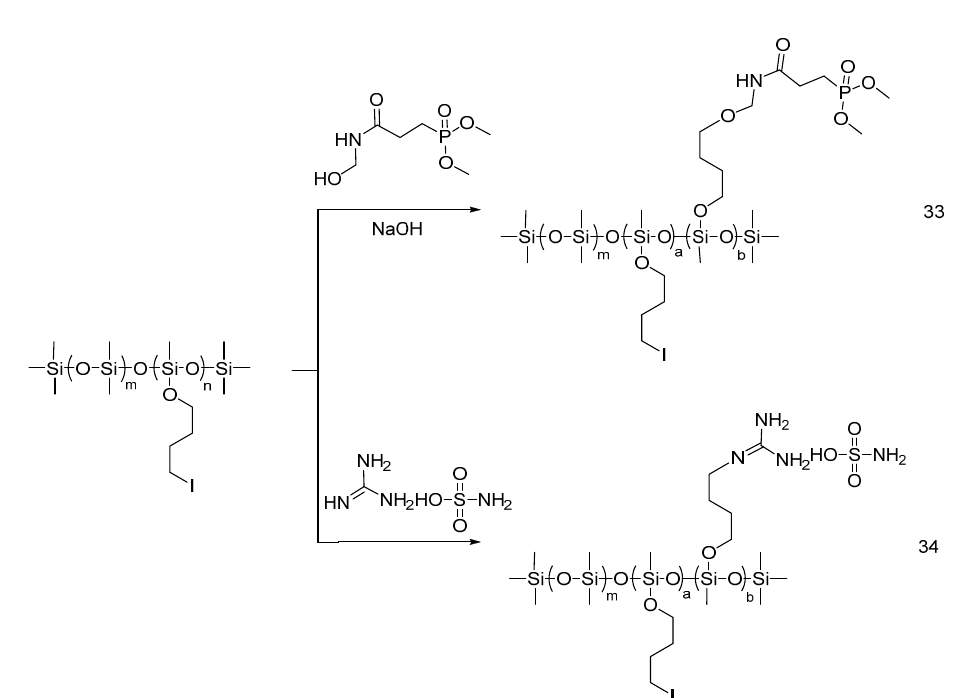
Figure 24. Representative synthetic approach for flame retardants ( 33 ) and ( 34 ).